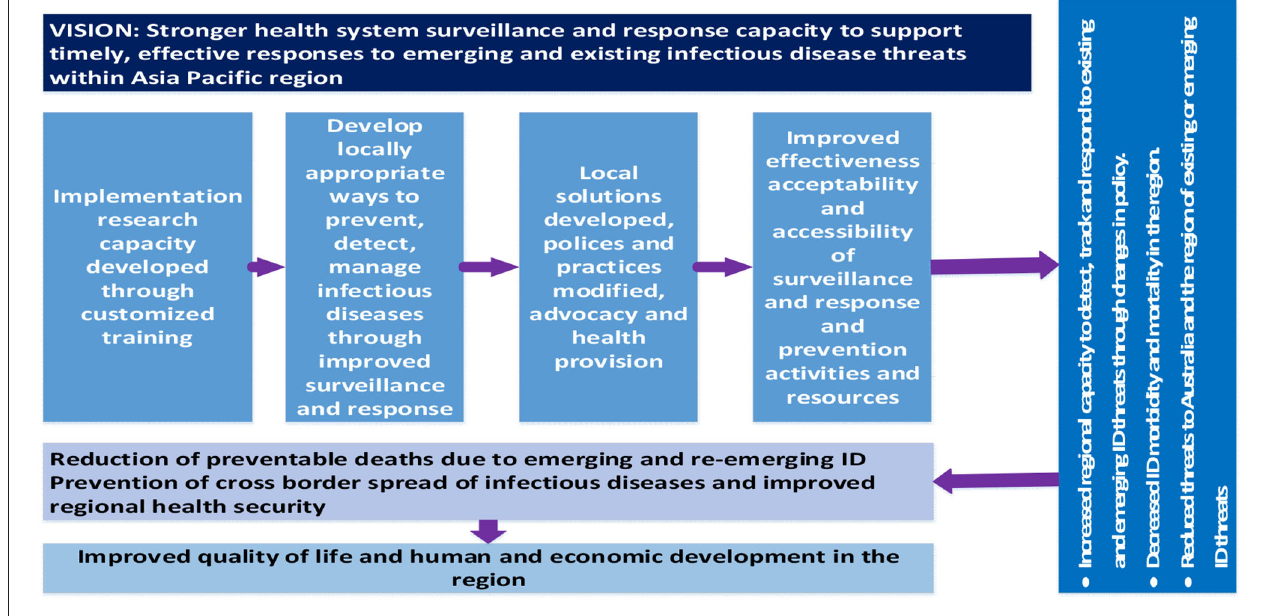
FIGURE 1 | Program logic guiding capacity-strengthening activities of the Partners in Tropical Health